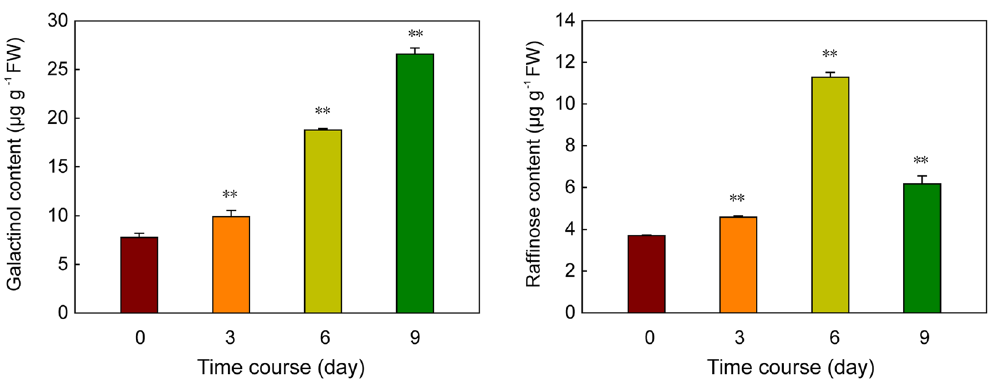
Figure 7. Changes in the content of galactinol and raffinose in sesame under osmotic stress. Two-week-old seedlings were subjected to osmotic (15% PEG 6000) stresses, and shoot samples were harvested at 0, 3, 6 and 9 days after treatment. Content of galactinol and raffinose was determined by LC-MS. Error bars indicate standard deviations based on three replicates. * P < 0.05; ** P < 0.01, t